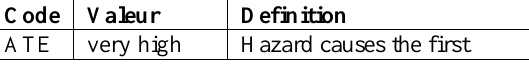
Table 1: Different scenario considered in the